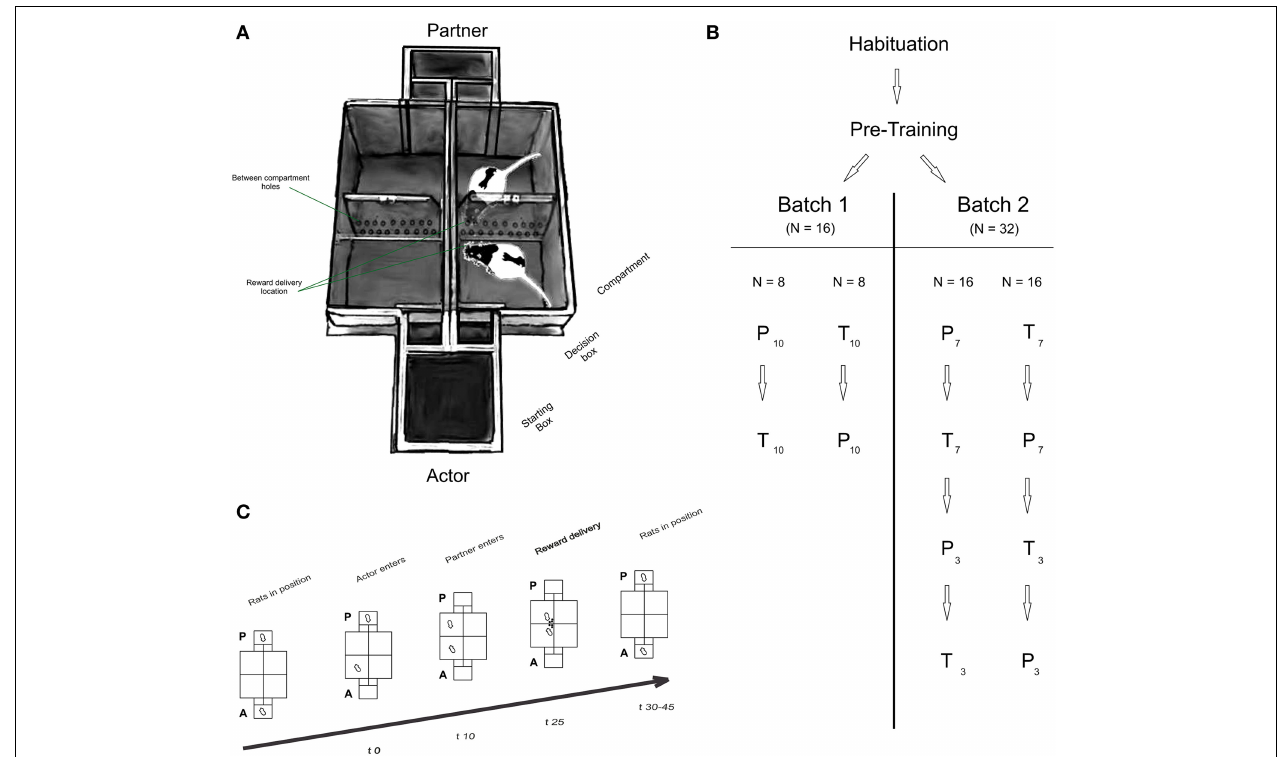
FIGURE 1 | (A) Experimental setup, (B) organization of groups and batches and (C) timeline of a typical trial. (A) Apparatus: each T Maze consisted of a starting box equipped with two independent doors that led to a decision box. A second door gave access to either compartment. Perforated and transparent walls were placed between compartments and between T Mazes to allow olfactory, auditory and visual communication between rats. A semi-automatic reward delivery system was placed at the intersection of each perforated wall, i.e., at the center of the maze (not shown on figure). (B) Organization of groups and batches of rats: all rats underwent habituation and pre-training procedures (See Supplementary Data). Actors in batch 1 ( N = 16) and batch 2 ( N = 32) were split in two groups, each starting in either the partner (P) or toy (T) condition. Each condition consisted of ten consecutive